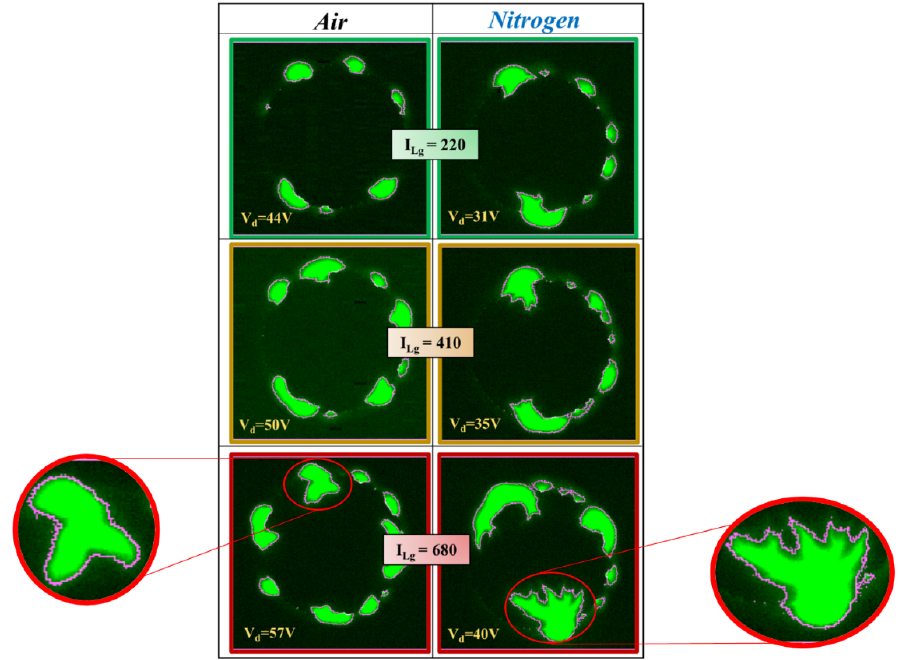
Figure 13. False colored iso-luminosity discharge images for air ( left column) and nitrogen ( right column).